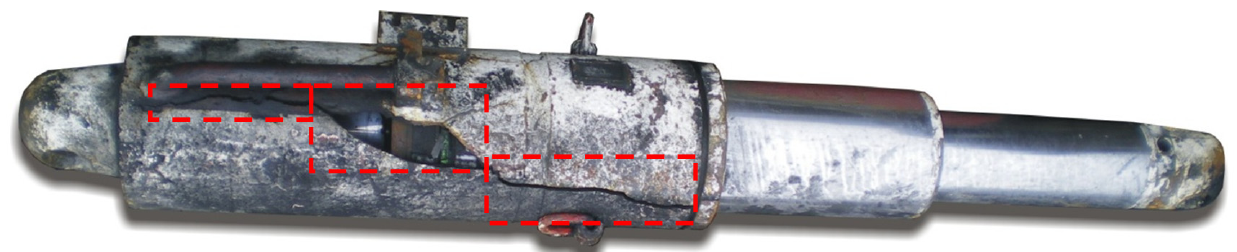
Figure 1. Area of a damaged hydraulic leg cylinder structure of a powered roof support.